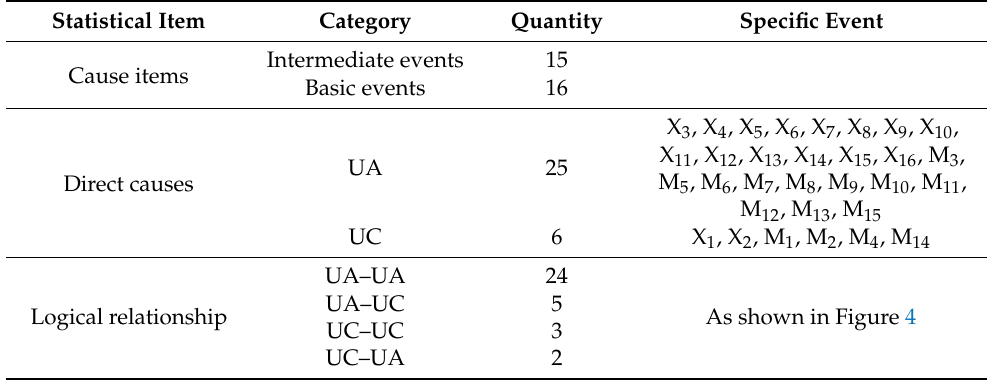
Table 2. Fault tree analysis results.